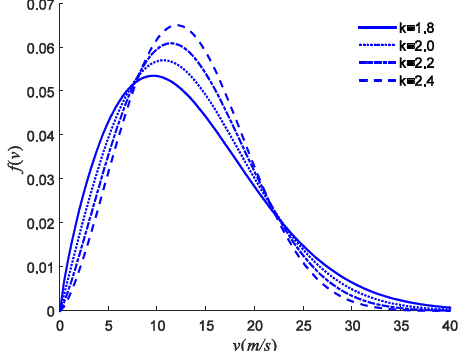
Figure 19. PDF of wind speed for different shape factors.